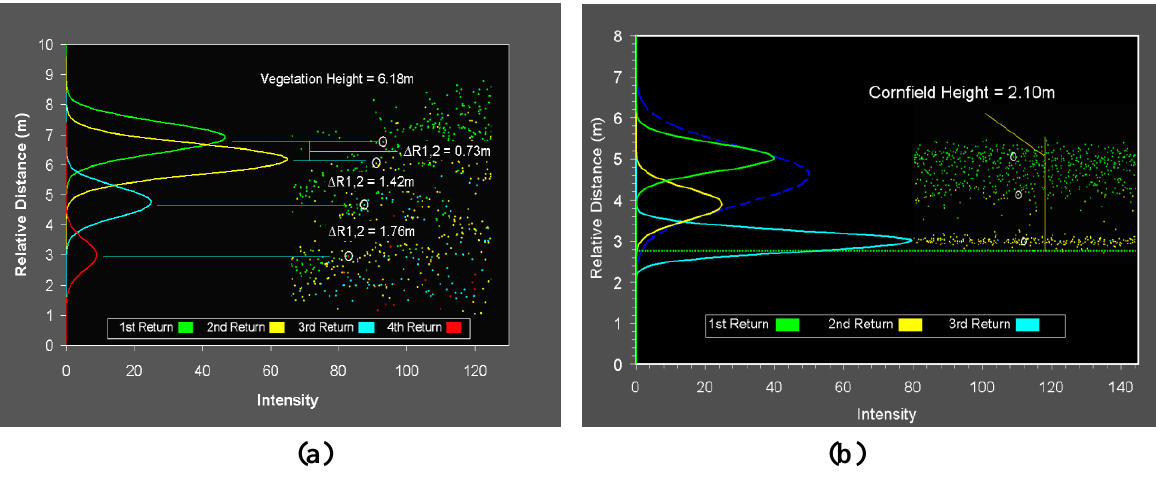
Figure 7. Illustration of the waveform modeling for ALTM-Orion data: (a) mixed vegetation data (refer to Figure 2(a)); (b) cornfield data (refer to Figure